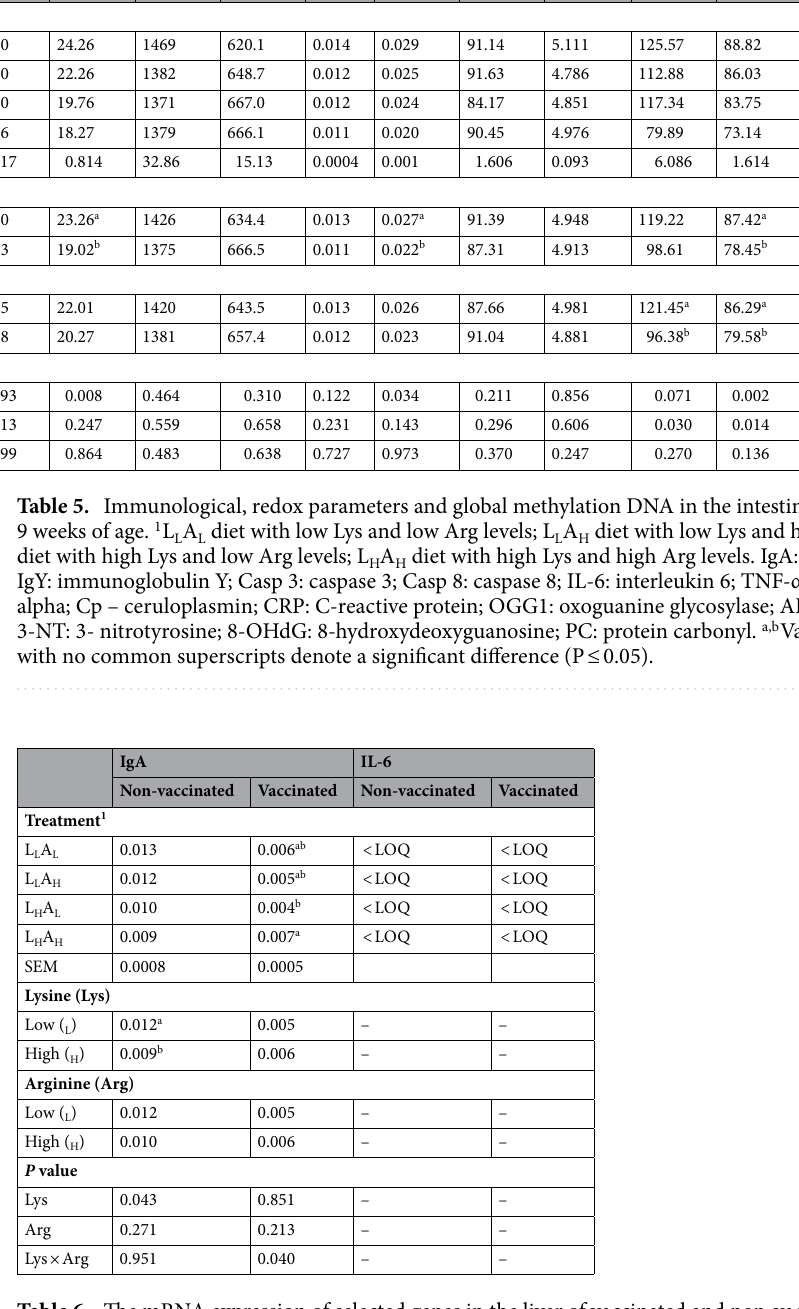
stage of inflammation or infection by interacting with the complement and Fc receptors on phagocytes 8 . The decrease in CRP levels in the small intestinal wall of turkeys fed diets with the higher Lys content (NRC + 10%), noted in the present study, suggests that the immune system of turkeys effectively protected them against patho- gens and infection. According to Calder and Yaqoob 39 , Arg is necessary for efficient proliferation of T and B